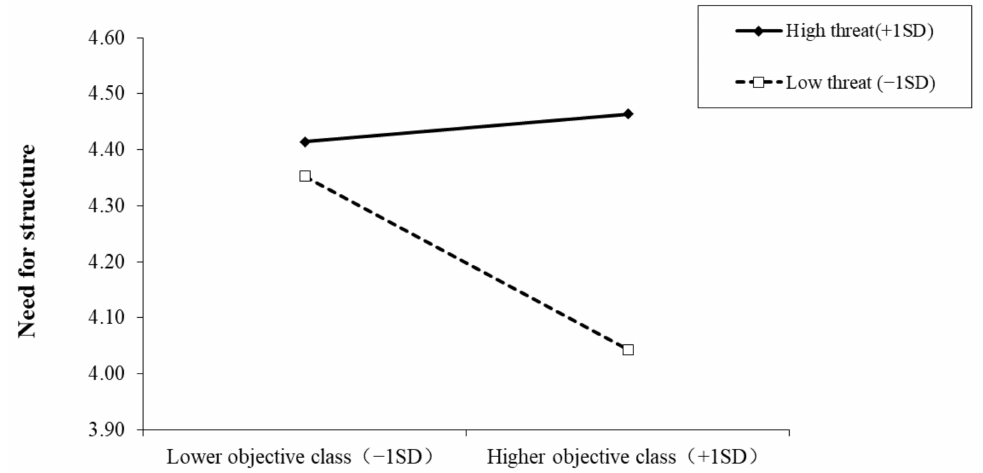
Figure 3. Interactive effect of pandemic threat and objective social class on need for structure. Note: Pandemic threat is graphed for two levels: high pandemic threat (1 SD above the mean) and low pandemic threat (1 SD below the mean).